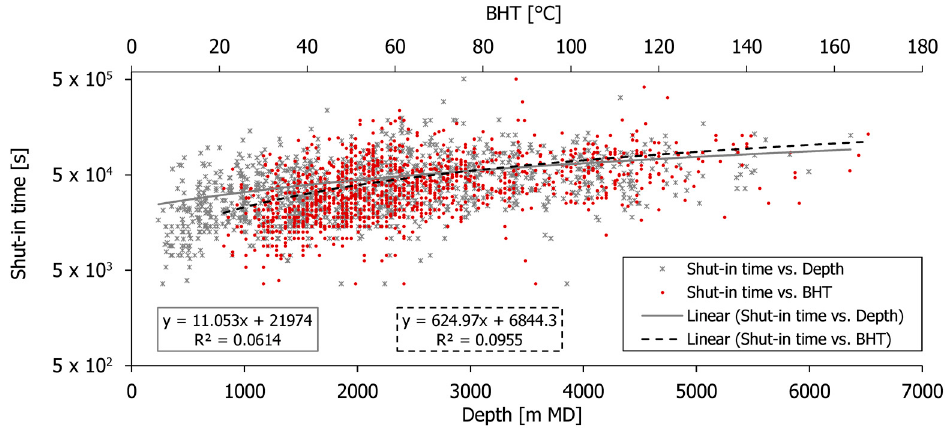
Figure 15. Shut-in times versus depth and BHT values.